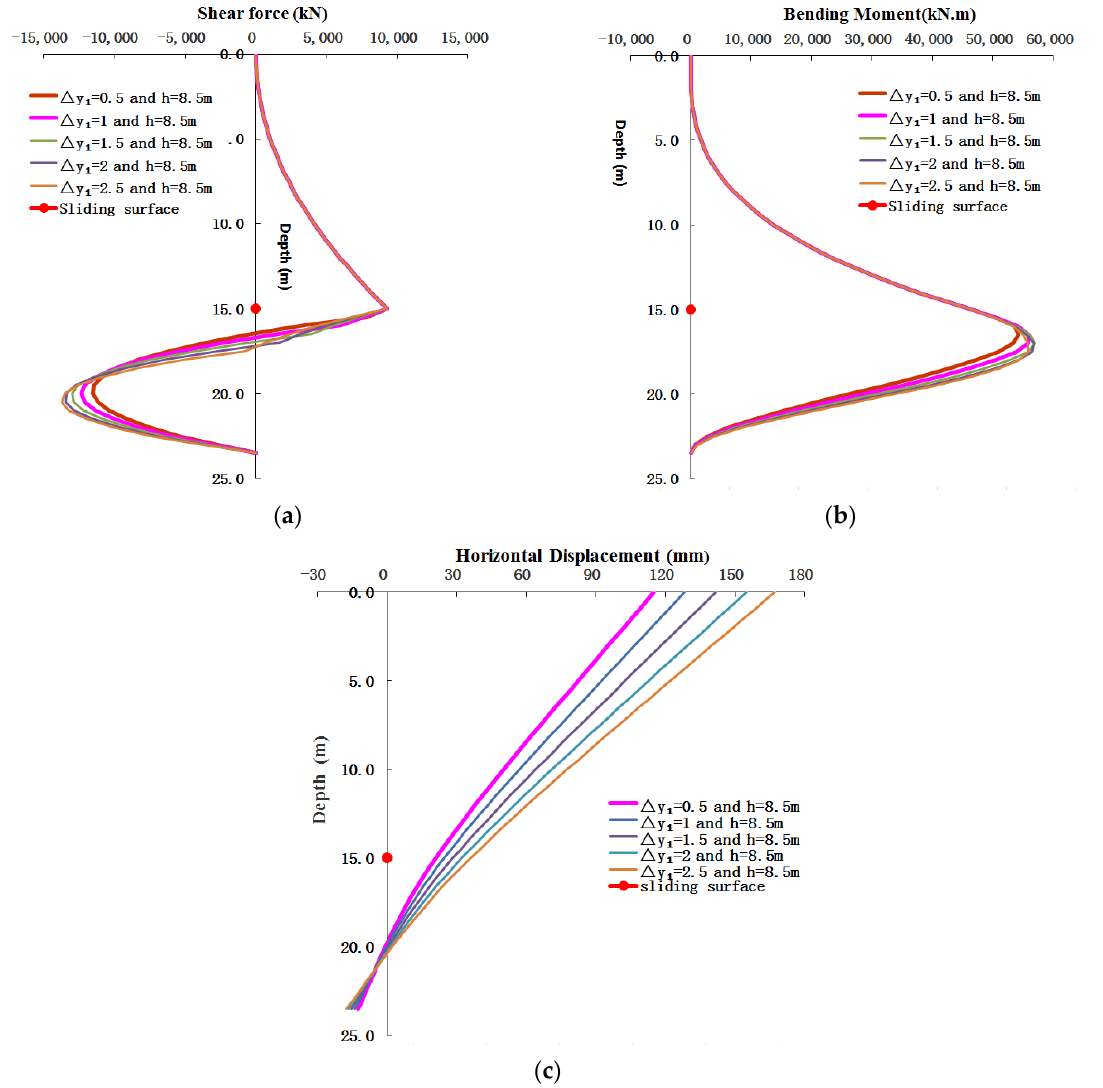
Figure 7. Calculated values of internal forces for piles of various thicknesses of first soft bedrock (Δy 1 ) with h = 8.5 m: ( a ) shear force; ( b ) bending moment; ( c ) horizontal displacement.